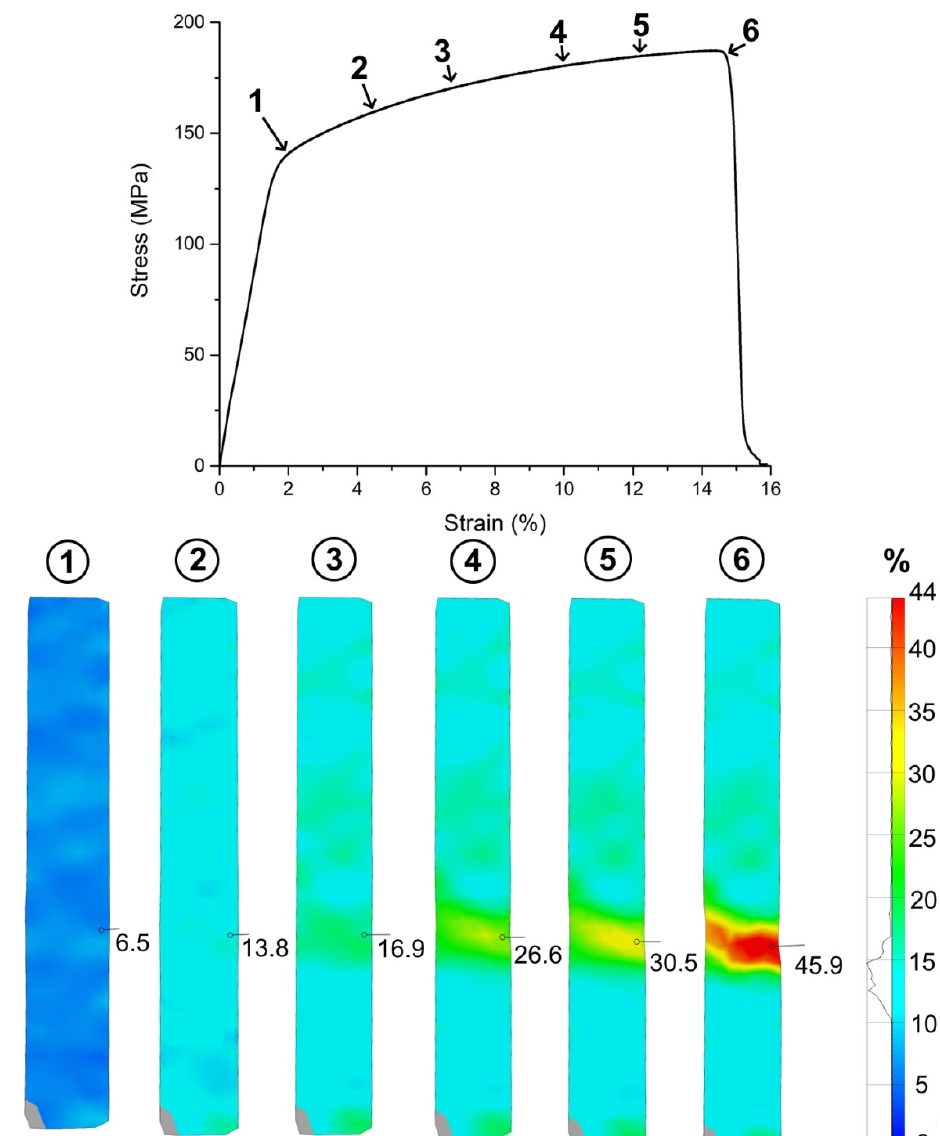
Figure 6. Typical stress–strain curve combined with DIC analysis; 1–6: DIC analysis at corresponding points on the stress-strain curve.